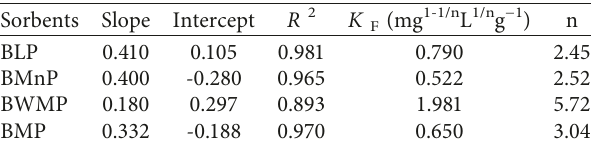
Table 4: Freundlich isotherm for Cr (VI) removal by base-treated